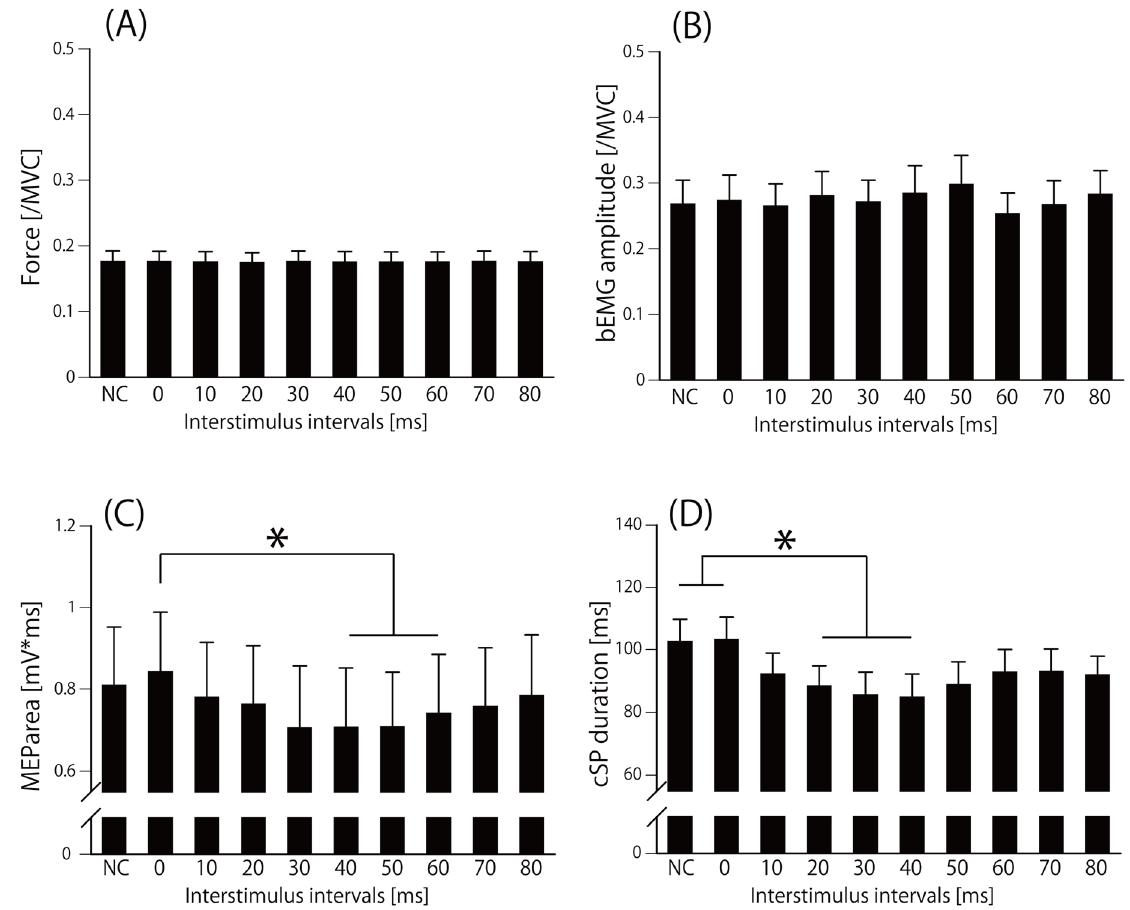
Figure 5. Actual output force ( / MVC) ( A ), bEMG amplitude ( / MVC) ( B ), MEP area (mV*ms) ( C ), and cSP duration (ms) ( D ) in the second experiment. Bars indicate the mean, and error bars indicate the standard error. * p < 0.05. bEMG, background electromyography; NC, not conditioned; MEP, motor evoked potential; cSP, cortical silent period.